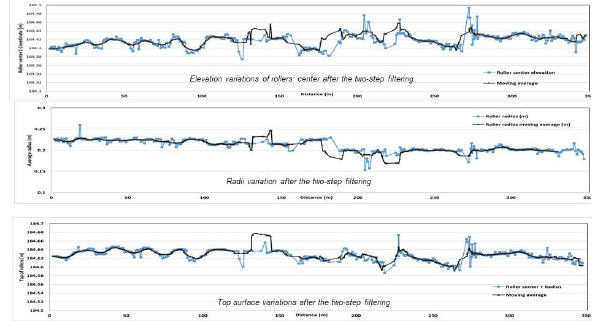
Figure 22. Centerline and radii variation after the two-stage